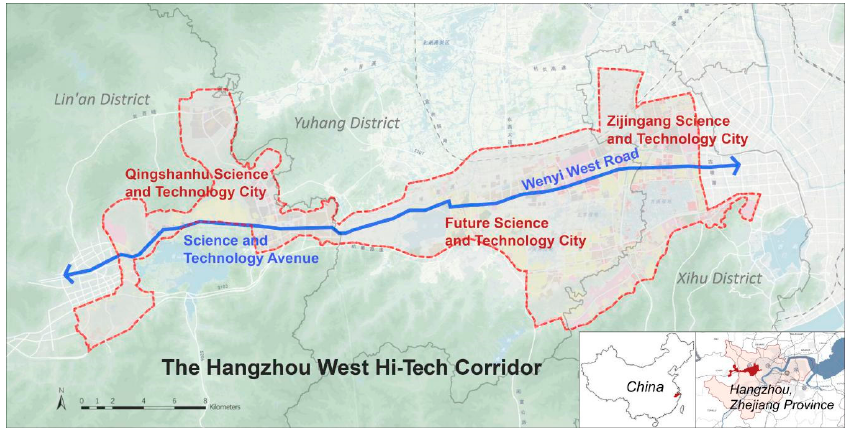
Figure 1. Location and spatial layout of the Hangzhou West Hi-Tech Corridor.